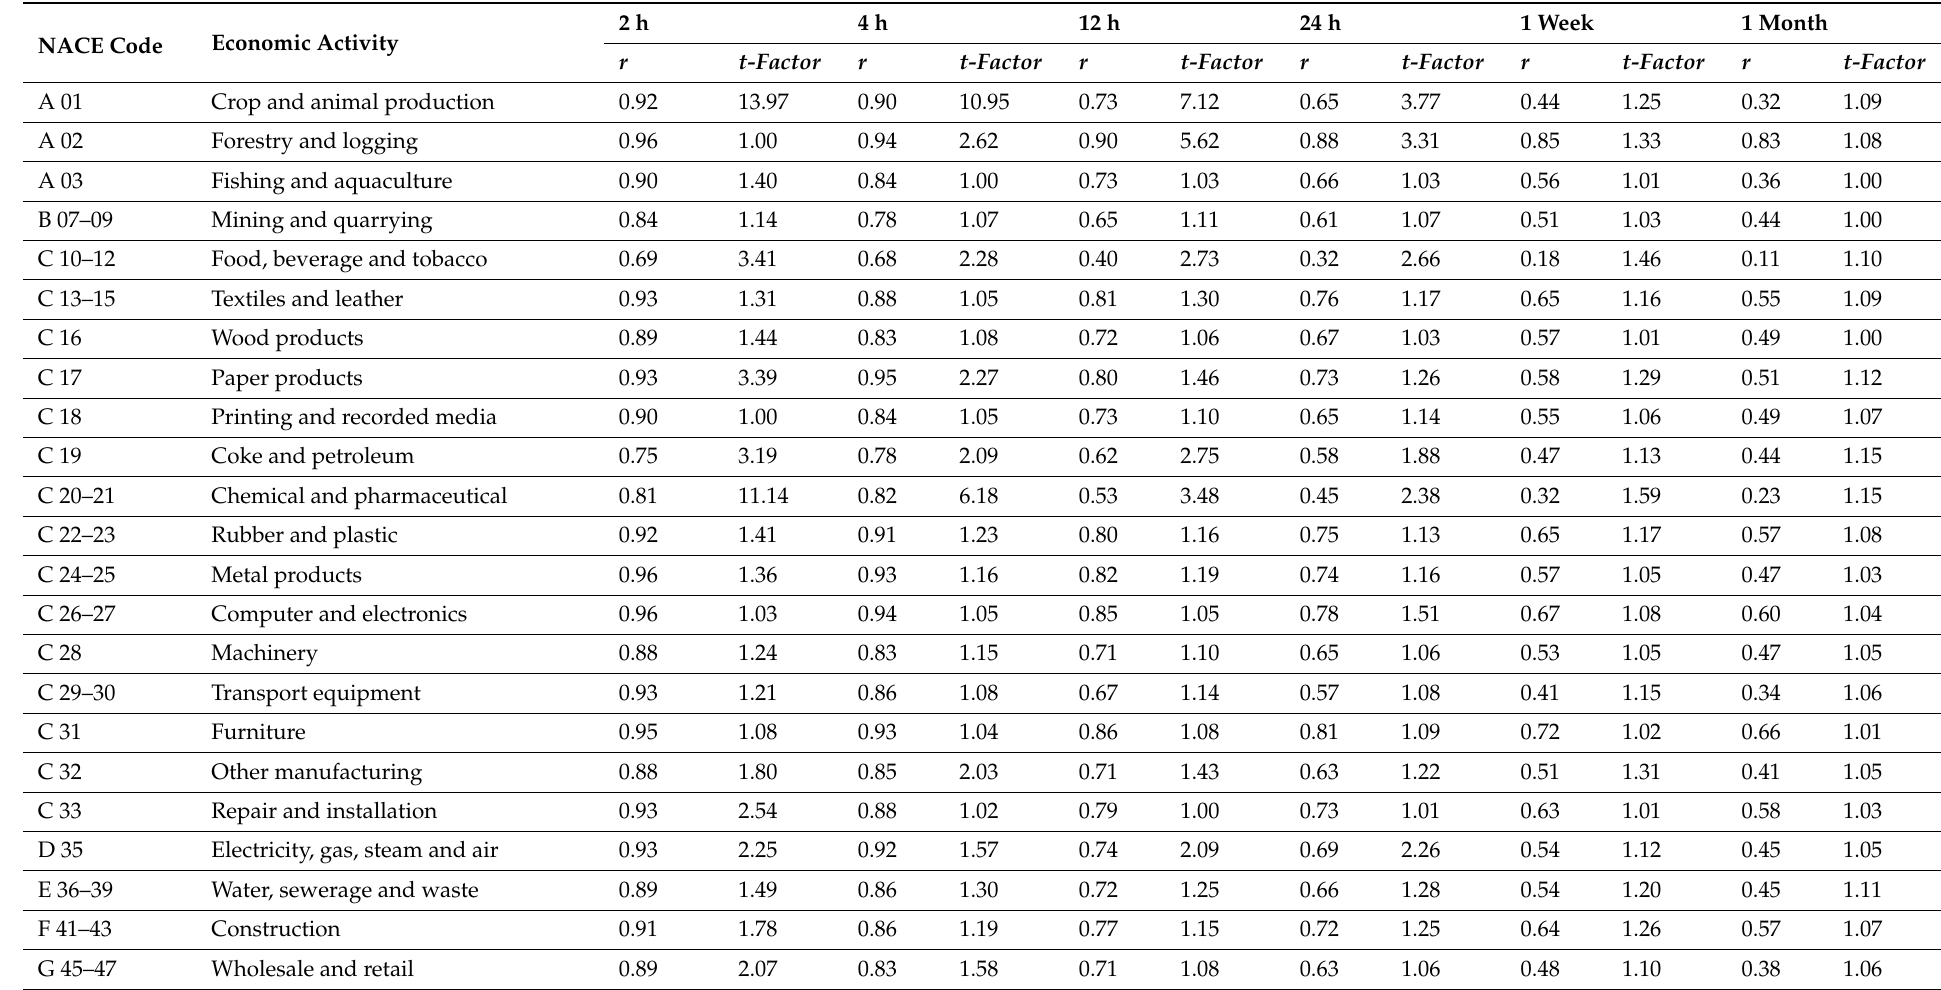
Table 2. Water supply resiliency factors ( r ) and time factors ( t-factor ) for all analyzed economic activity sectors and water disruption